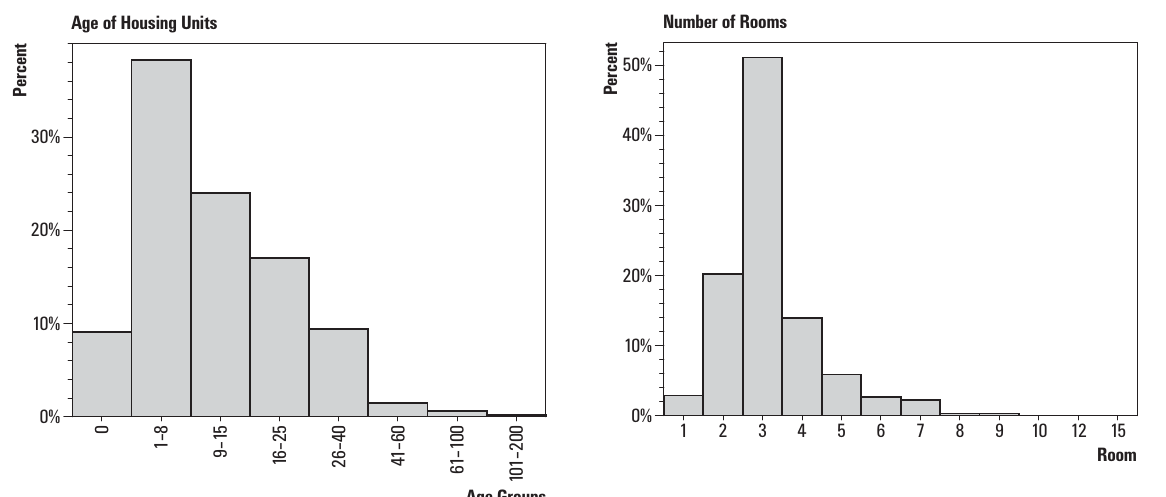
Figure 2. Age of the housing units